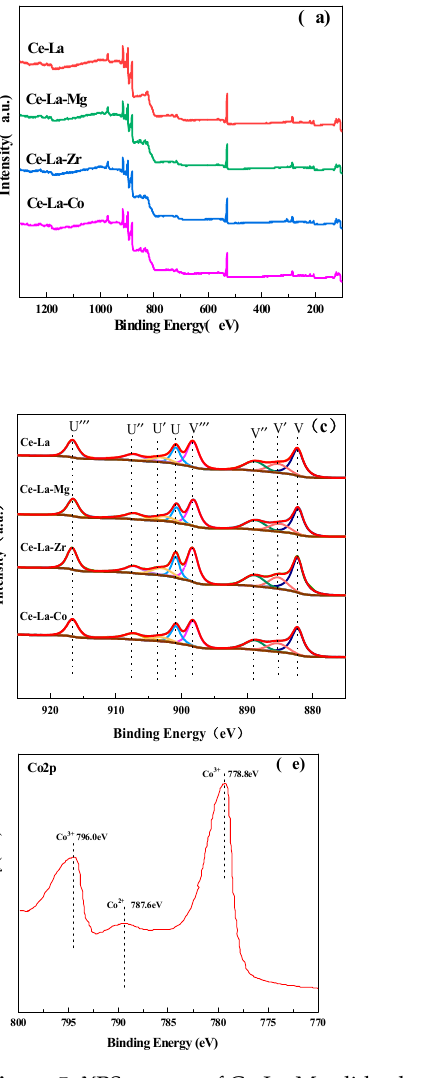
( ∼ 903.4 eV), U ( ∼ 900.9 eV) represent the spin-orbit splitting peaks of Ce 3d 3/2 , and V (cid:48)(cid:48)(cid:48)